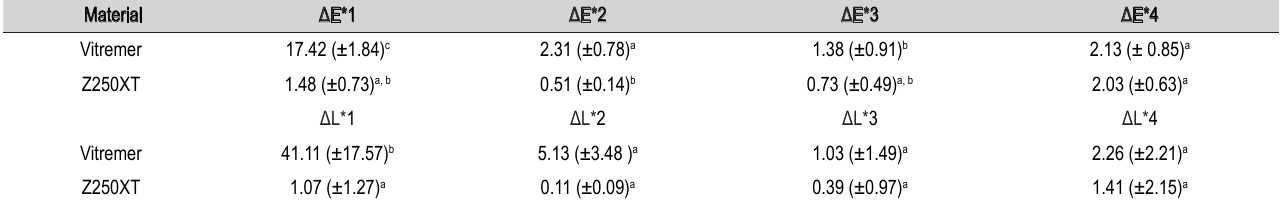
Table 3 - Mean values (Standard deviation) of and Color variation ΔE* and Lightness variation ΔL* of Vitremer and Z250 XT between each time period: Δ1 (between T1 and T0), Δ2 (between T2 and T1), Δ3 (between T3 and T2), Δ4 (between T4 and T3).